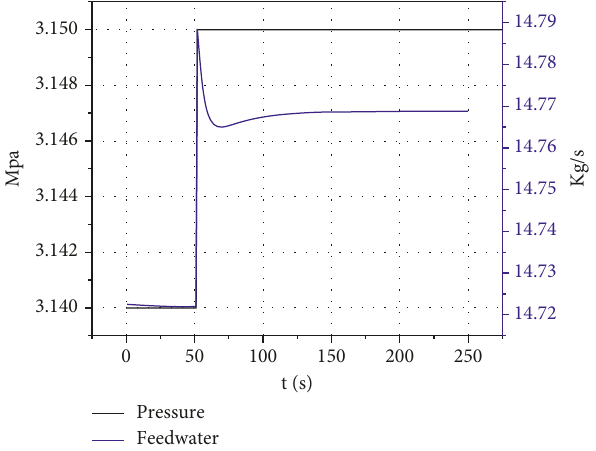
Figure 18: Simulation curves of pressure and feedwater